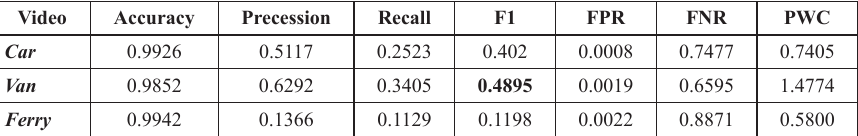
Table 8. Performance metrics results of applying Fuzzy Choquet Integral model